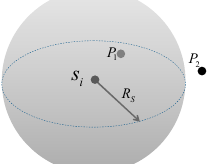
Figure 2. 3D Boolean perception model.